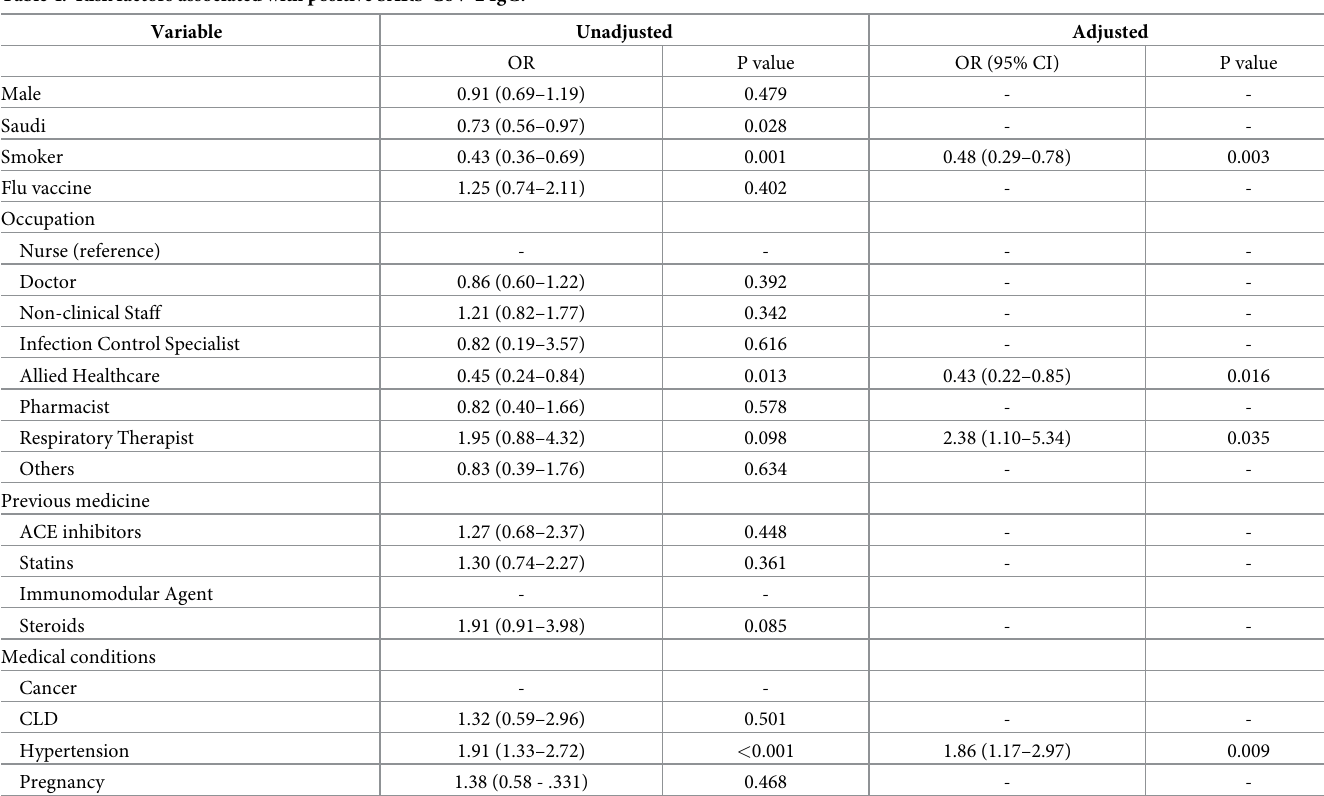
Table 4. Risk factors associated with positive SARS-CoV-2